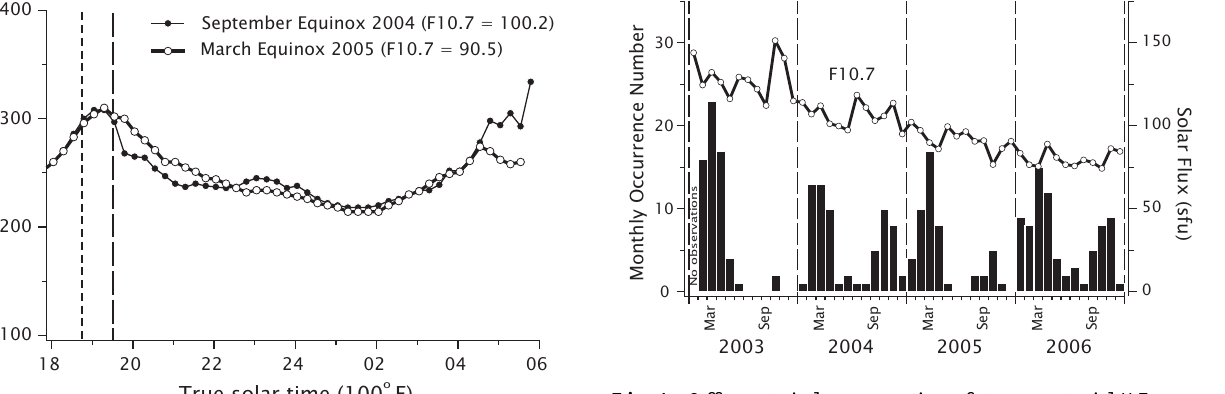
Fig. 4. Off-great-circle propagation of transequatorial HF waves between Australia and Japan, which is related to the formation of equatorial spread F (Kelleher and R¨ottger, 1973; R¨ottger,